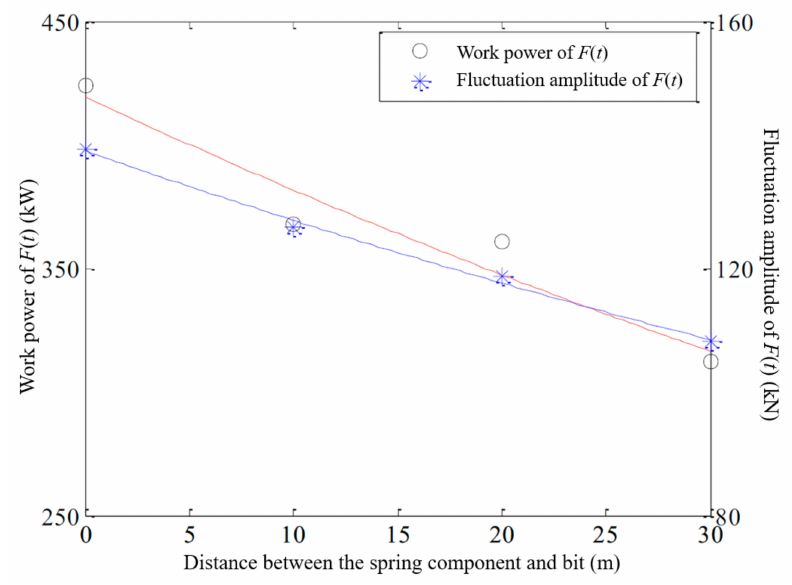
Figure 24. The variation of work power and fluctuation amplitude of F ( t ) with spring position. The fluctuation amplitude of F ( t ) decreased linearly with the increasing of distance between spring and